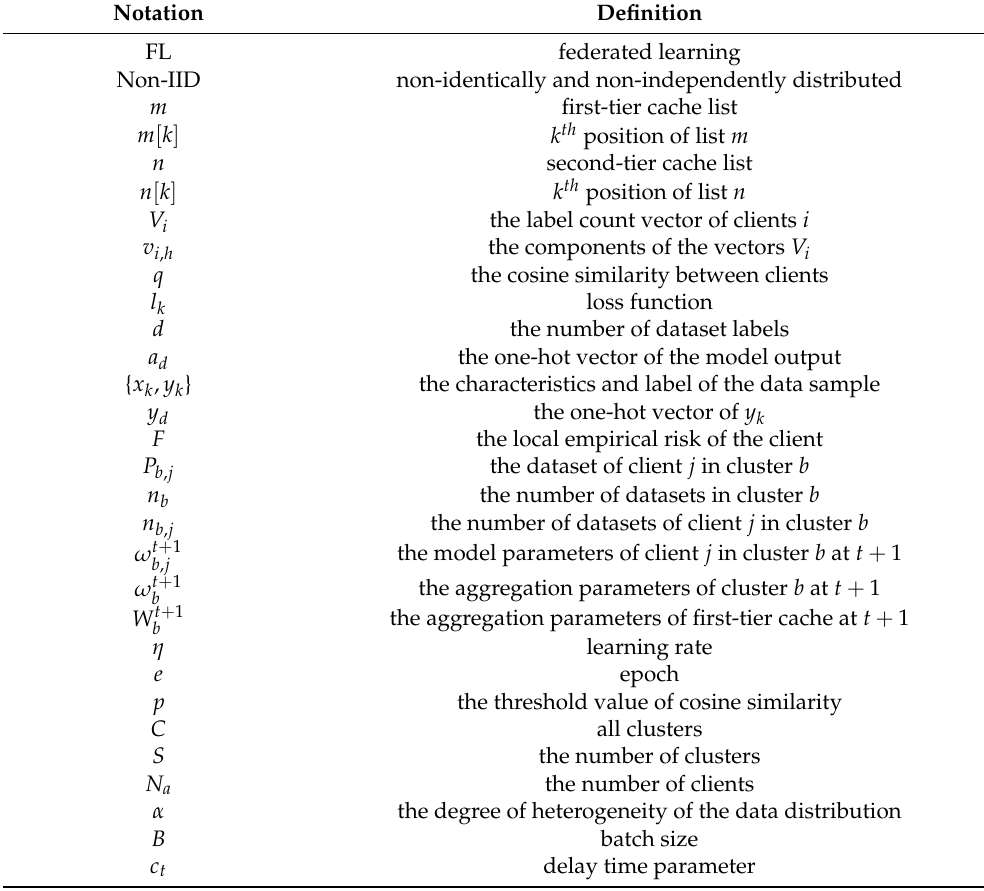
Table 1. Notion and